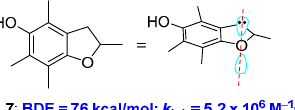
Figure 3. Role of conformations on resonance stabilization of ArO • .